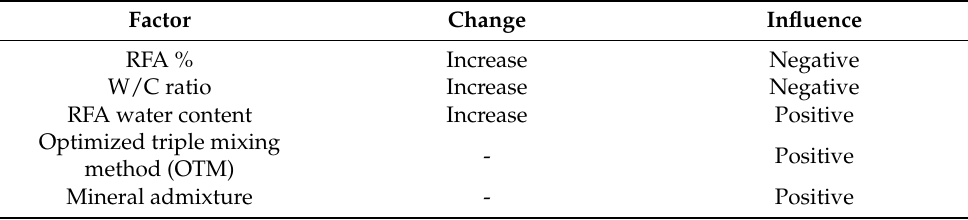
Table 1. The influence of different factors on the impermeability of